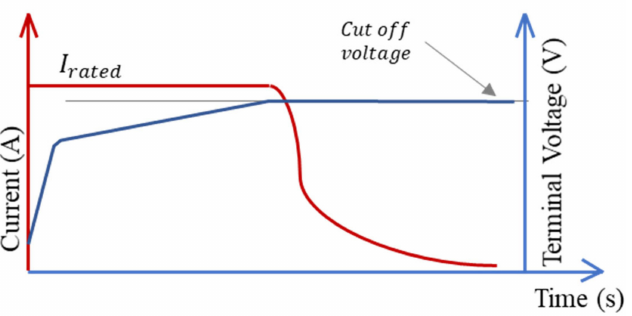
Figure 3. Schematic diagram of the Constant Current Constant Voltage (CC-CV)